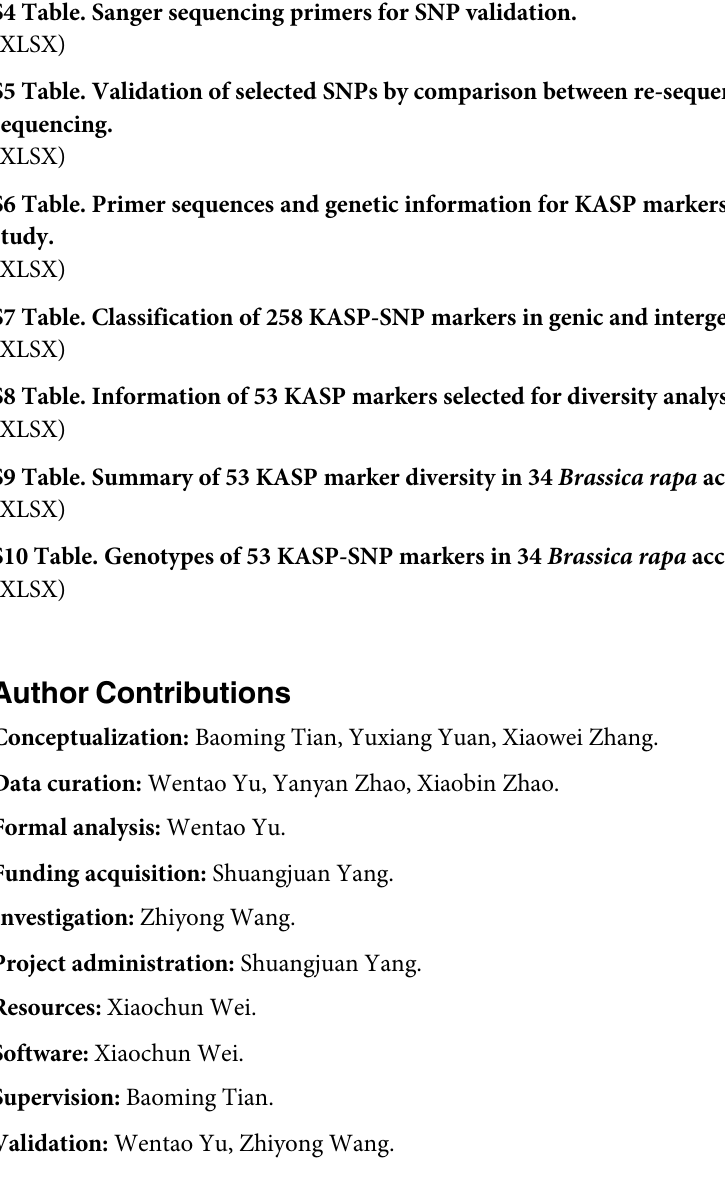
S1 Table. 34 Brassica rapa accessions used in this study. S2 Table. Number and density of SNPs on each chromosome. S3 Table. Number of SNPs in pairwise comparisons of the four Chinese cabbage DH lines and the reference genome Chiifu-401-42. S4 Table. Sanger sequencing primers for SNP validation. S5 Table. Validation of selected SNPs by comparison between re-sequencing and Sanger sequencing. S6 Table. Primer sequences and genetic information for KASP markers developed in this study. S7 Table. Classification of 258 KASP-SNP markers in genic and intergenic regions. S8 Table. Information of 53 KASP markers selected for diversity analysis. S9 Table. Summary of 53 KASP marker diversity in 34 Brassica rapa accessions. S10 Table. Genotypes of 53 KASP-SNP markers in 34 Brassica rapa